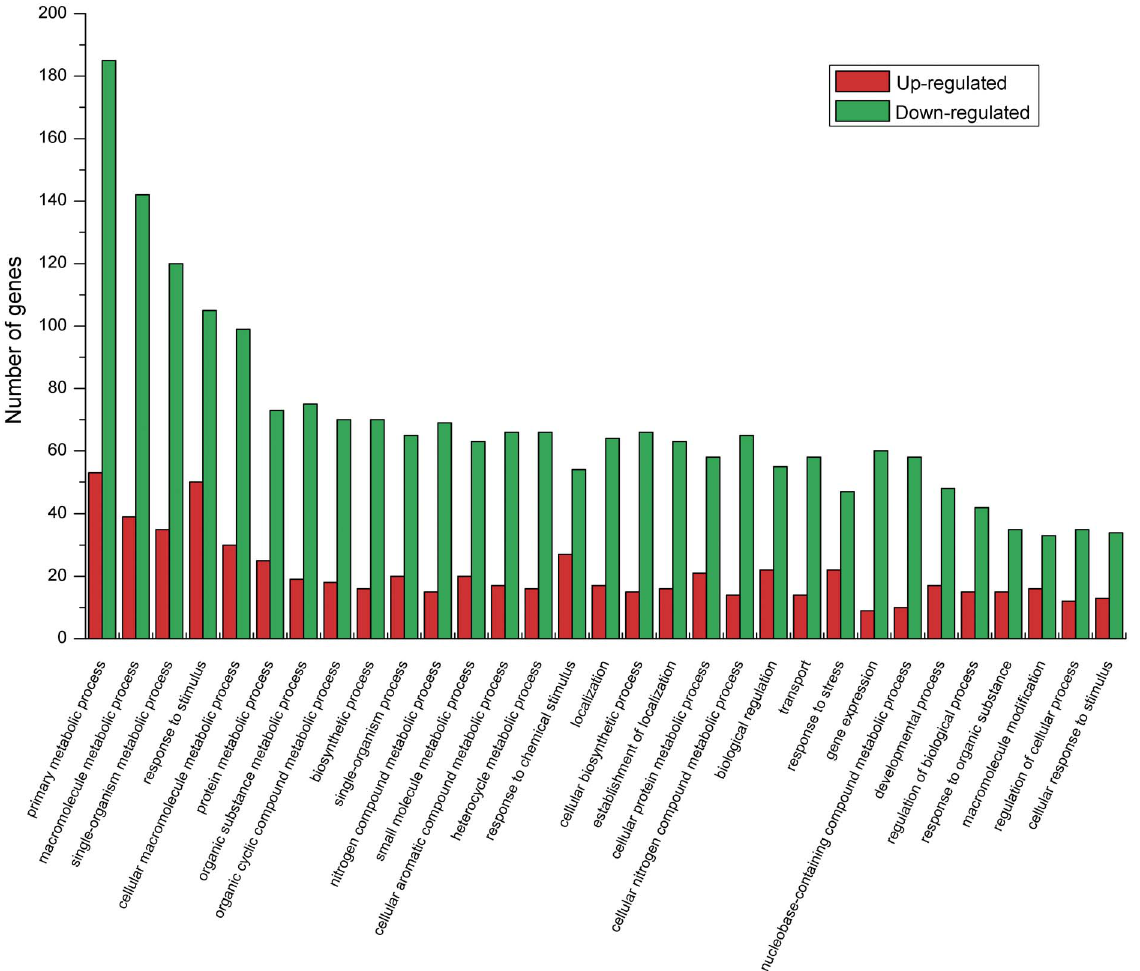
Figure 2. Gene classification based on gene ontology (GO) for DEGs in C and P libraries of R.soongorica . Only the biological processes were used for GO analysis. C represents the control group; P represents the PEG-treated group.